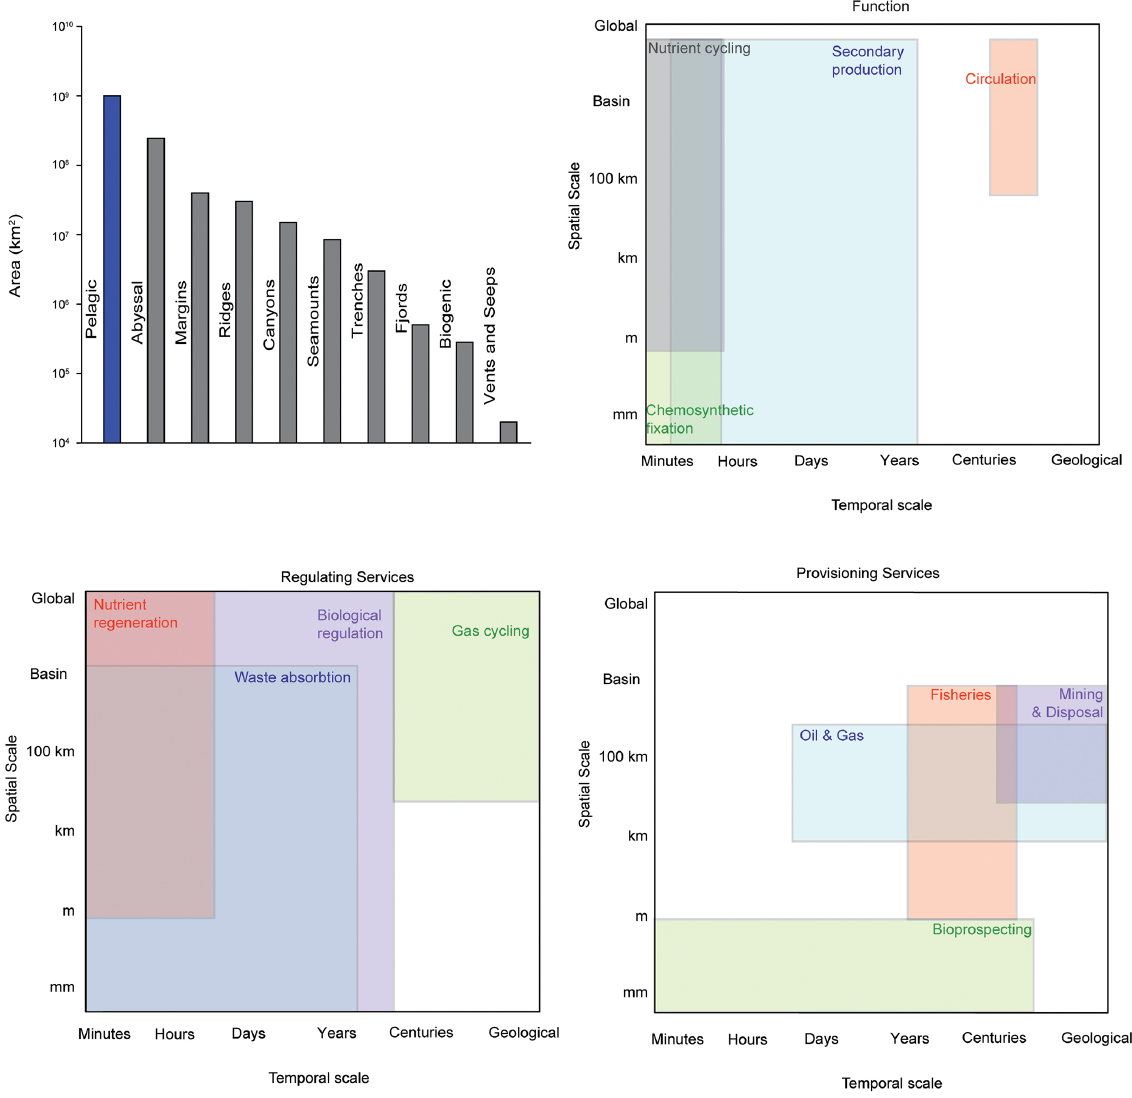
Figure 3. (A) The spatial extent of each of the main deep-sea habitats (pelagic is in km 3 , while all other habitats are in km 2 ; derived from Ramirez-Llodra et al., 2010.). Note that many of these habitats can be any range of size from small to those depicted. The relationship between spatial and temporal scales for (B) supporting, (C) regulating and (D) provisioning services of the deep sea. Note the log scale in (A) and the approximate scales in (B–D) . Geological = thousands to millions of